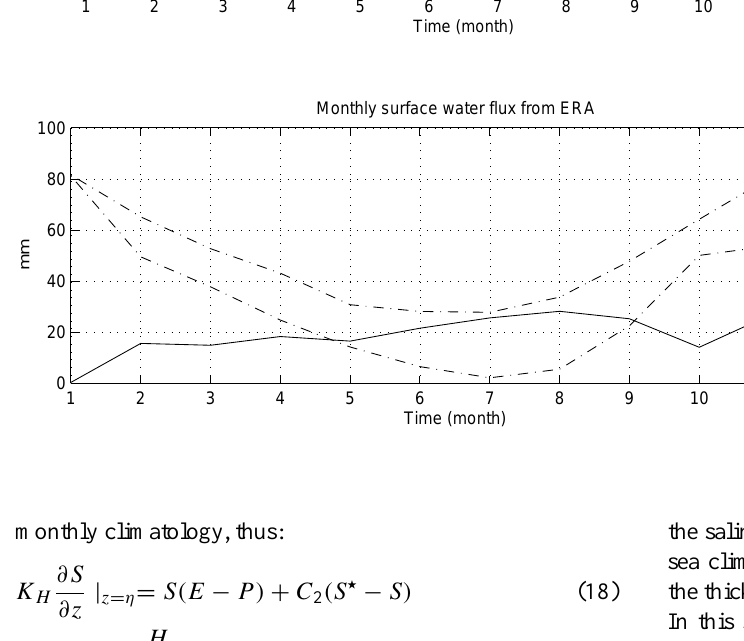
Fig. 5. Annual cycle of the total heat flux (solid line), solar radiation from ERA (dash-dot line) and the upward heat flux (dashed line). Units are W/m 2 .